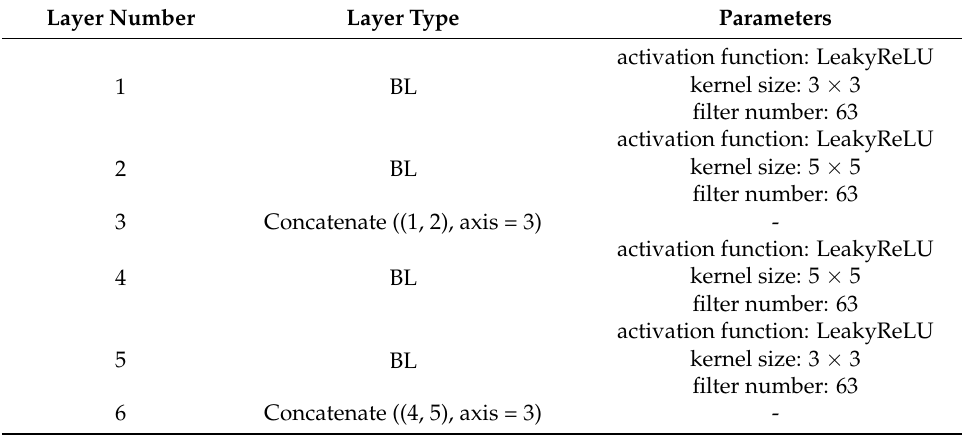
Table 3. Preliminary, convolutional neural network